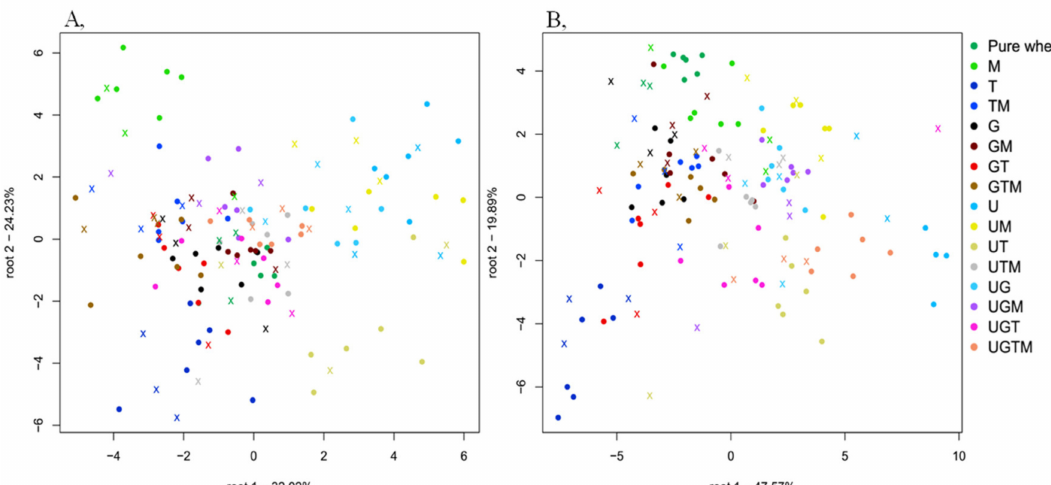
Figure 5. Classification plots of handheld spectrometer for the 15-mixture combination (( A ) optical glass, and ( B ) commercial LDPE plastic bag) using the data of samples with the lowest adulteration level of 0.5% w / w and the pure whey protein powder. U = urea, G = glycine, T = taurine, M = melamine. Spectral pre-processing: Savitzky-Golay smoothing and multiplicative scatter correction